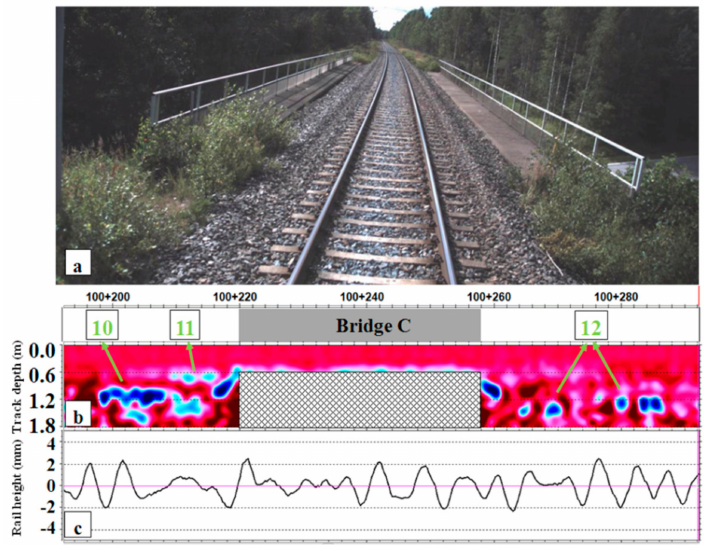
Figure 10. Measurement results of Transition Zone C: ( a ) photograph of the track; ( b ) the moisture profile; and, ( c ) the longitudinal track